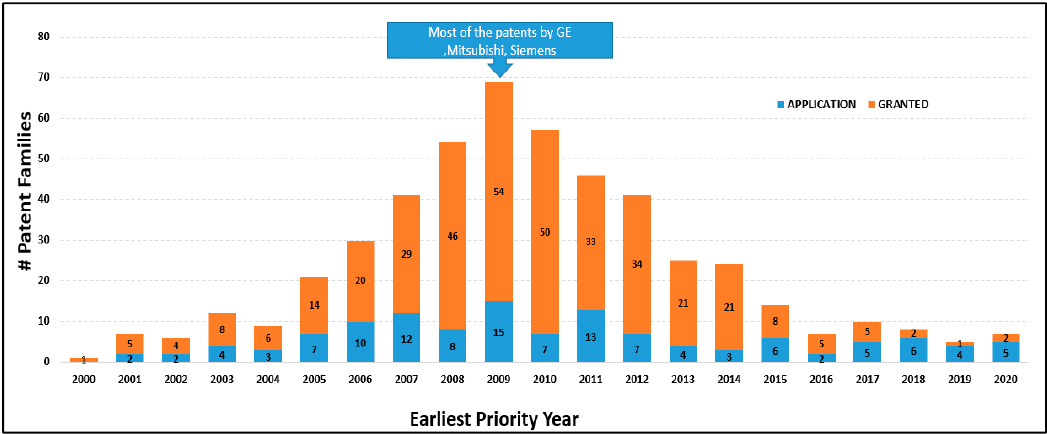
Figure 4. Patent filling—first application year.